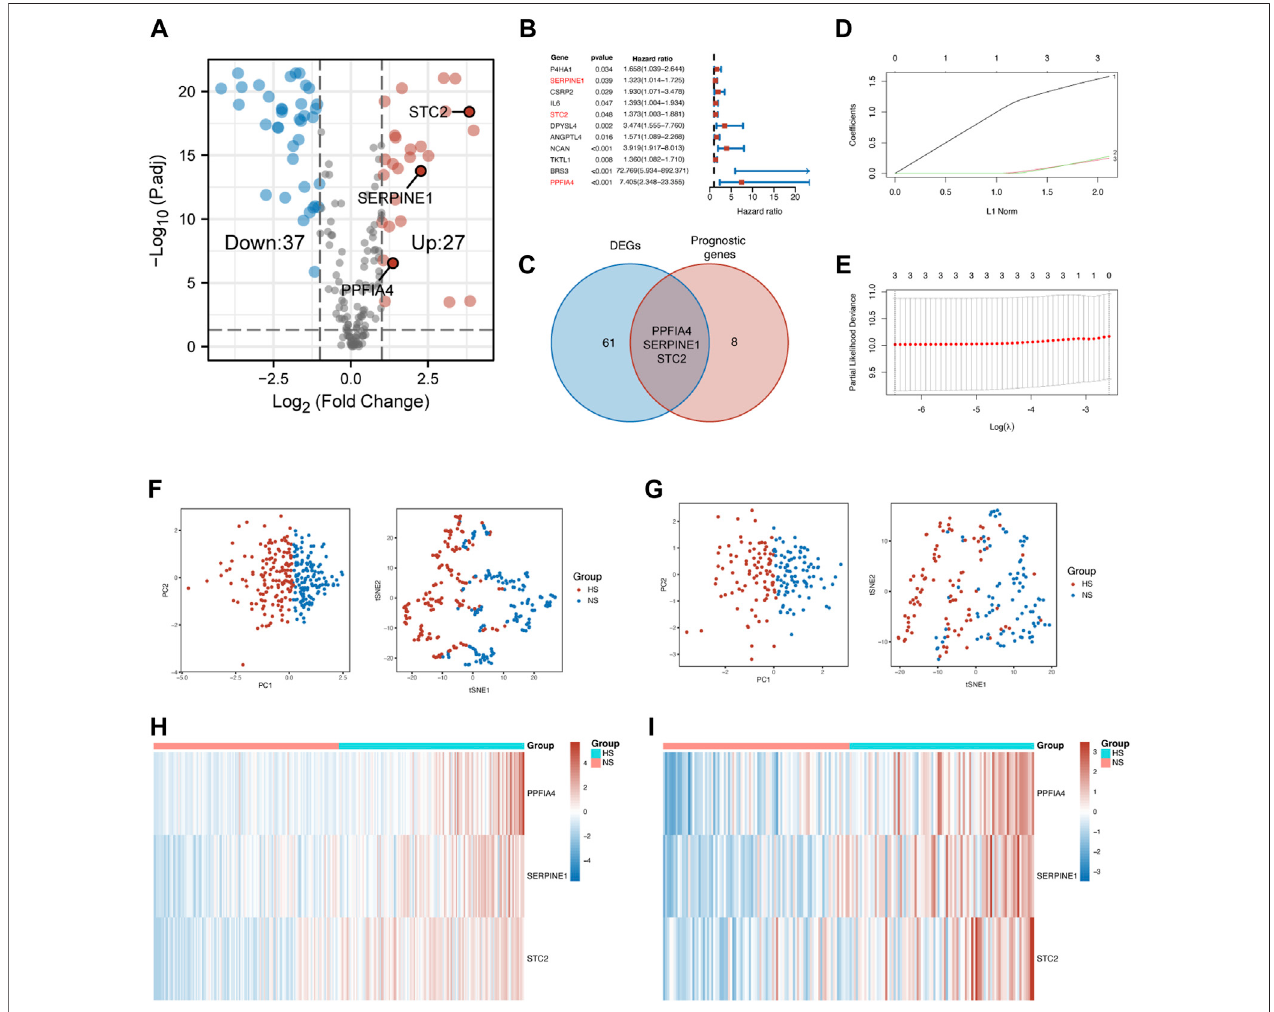
FIGURE2| Construction ofthe prognostic model. (A) The volcanoplot showed hypoxia-relatedDEGs extracted from theTCGA-COAD cohort. (B) Theforestplot displayed the hypoxia-related prognostic genes extracted from the TCGA-COAD cohort. Three hub genes were marked in red font. (C) The Venn diagram showed that the intersection of DEGs and prognostic genes were three hub genes, including PPFIA4, SERPINE1, and STC2. (D) 20-Time cross-validation for tuning parameter selection in the LASSO Cox model. The plot of LASSO coef fi cients (E) showed the best choice of the number of these genes was 3. The PCA and t-SNE scatter plots con fi rmed that the risk score model could precisely classify patients into two different groups in the training (F) and validation (G) sets. The heatmap visualized different expression patterns of hub genes in NS and HS in the training (H) and validation (I) sets. DEGs: differentially expressed genes.